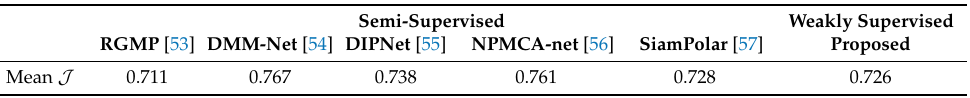
Figure 8. VOS results of the proposed algorithm in the weakly supervised scenario on the DAVIS2017 dataset: ( a ) point interaction of target objects in 1st frames, ( b ) segmentation results in 1st frames, and ( c – f ) segmentation results in subsequent frames. From top to bottom, “Dogs-jump”, “Gold-fish”, “Horsejump-high”, “Loading”, “Motocross-jump”, “Pigs”, “Lab-coat”, and “Soapbox”. Table 11. Comparison of the proposed weakly supervised algorithm with the conventional semi- supervised algorithms on SegTrack